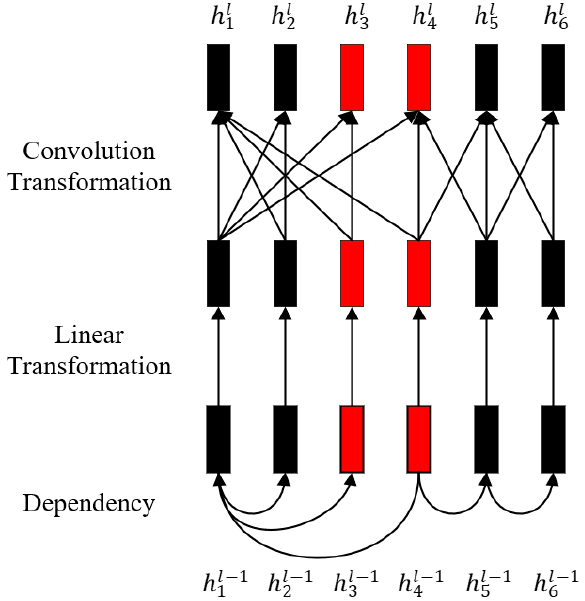
Figure 3. An example of attention-enhanced graph convolutional network (AEGCN) layer.